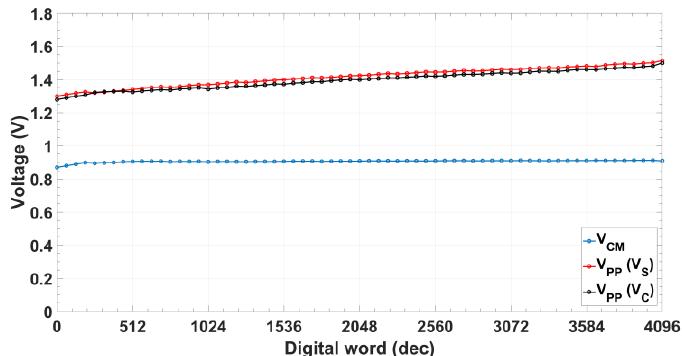
Figure 10. Oscillator common mode (V CM ) and peak-to-peak (V PP ) voltage of quadrature signals.